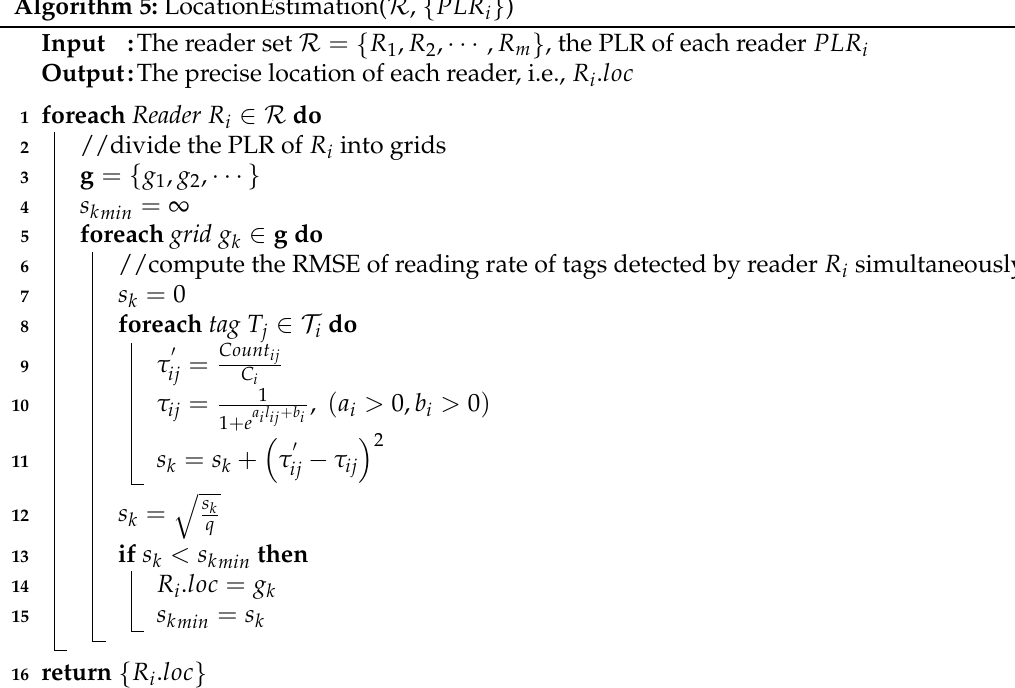
Algorithm 5: LocationEstimation( R , { PLR i }